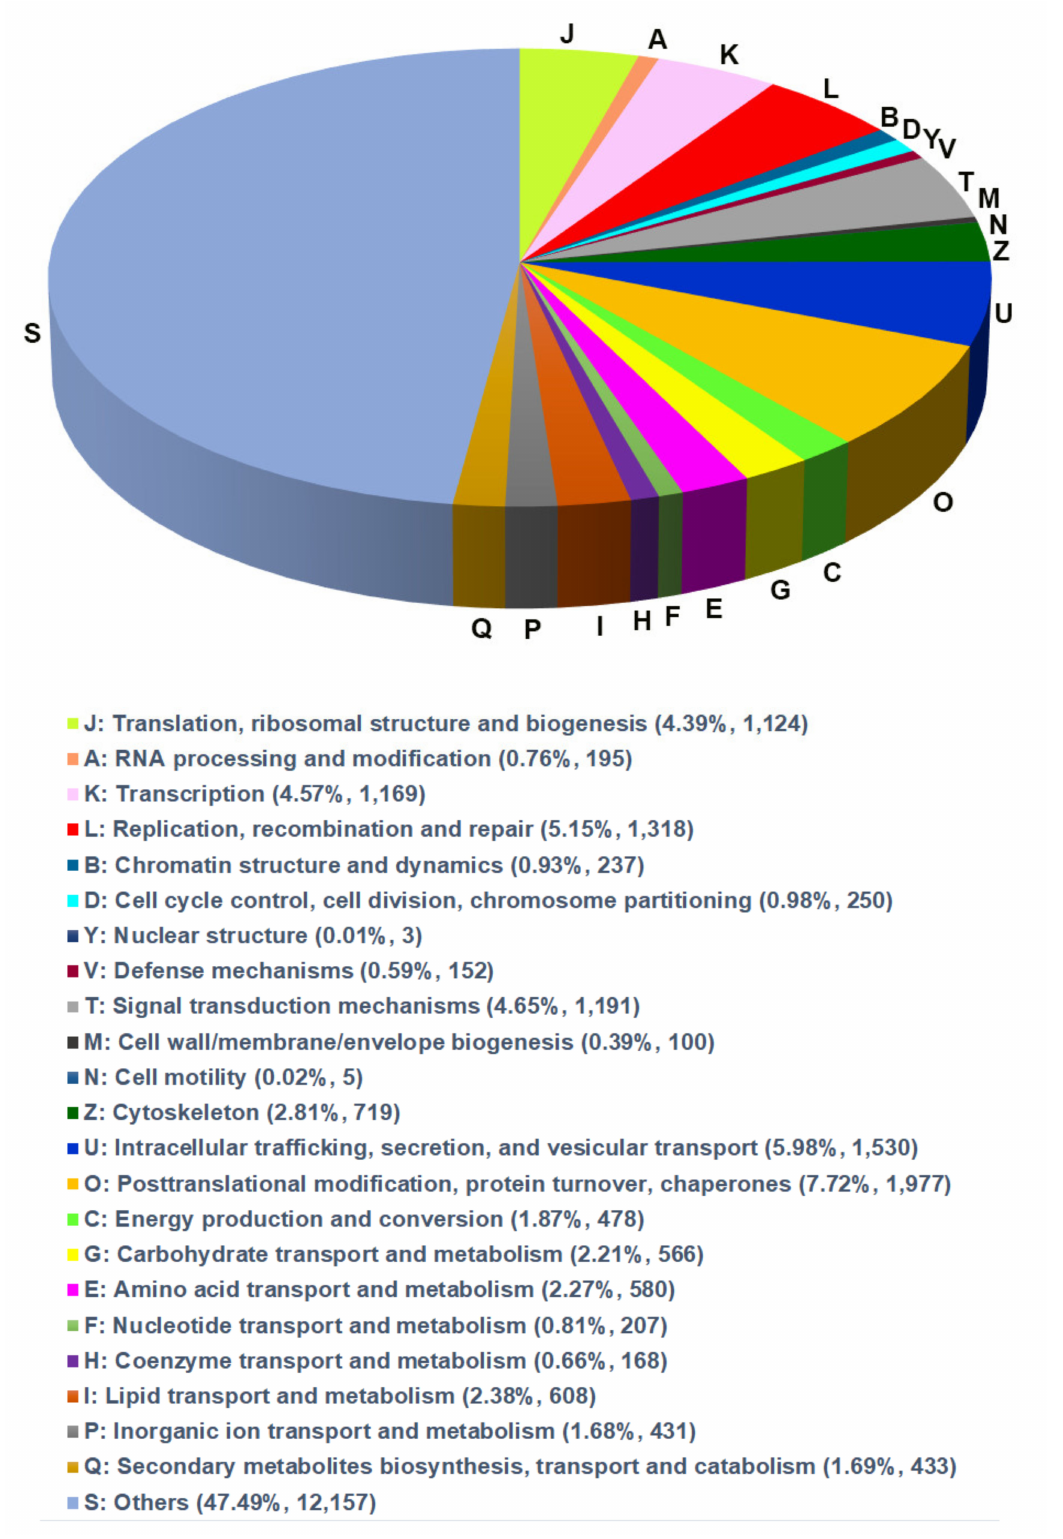
Figure 2. Annotations of the annotated unigenes. The annotated unigenes are mapped to the annotation of the corresponding orthologous groups in EggNOG (evolutionary genealogy of genes)